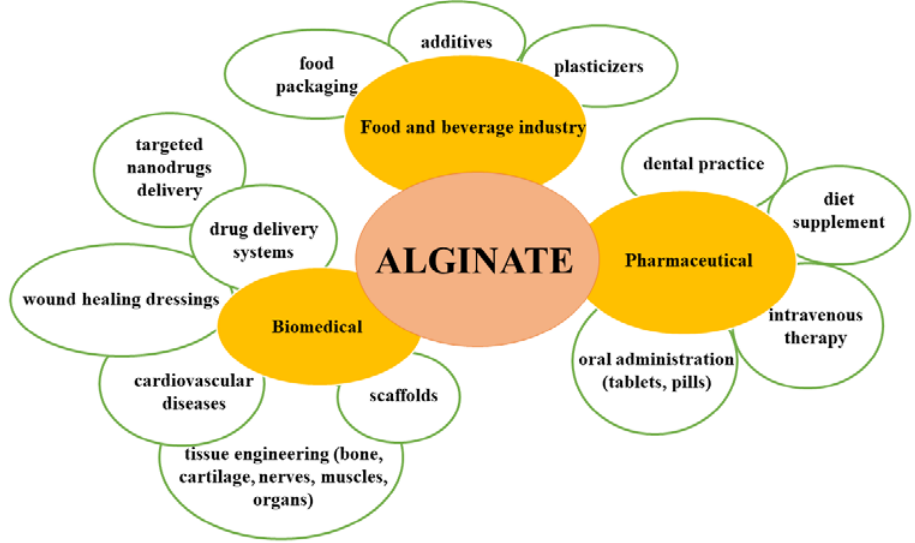
Figure 2. Highlighted biomedical applications of alginate.